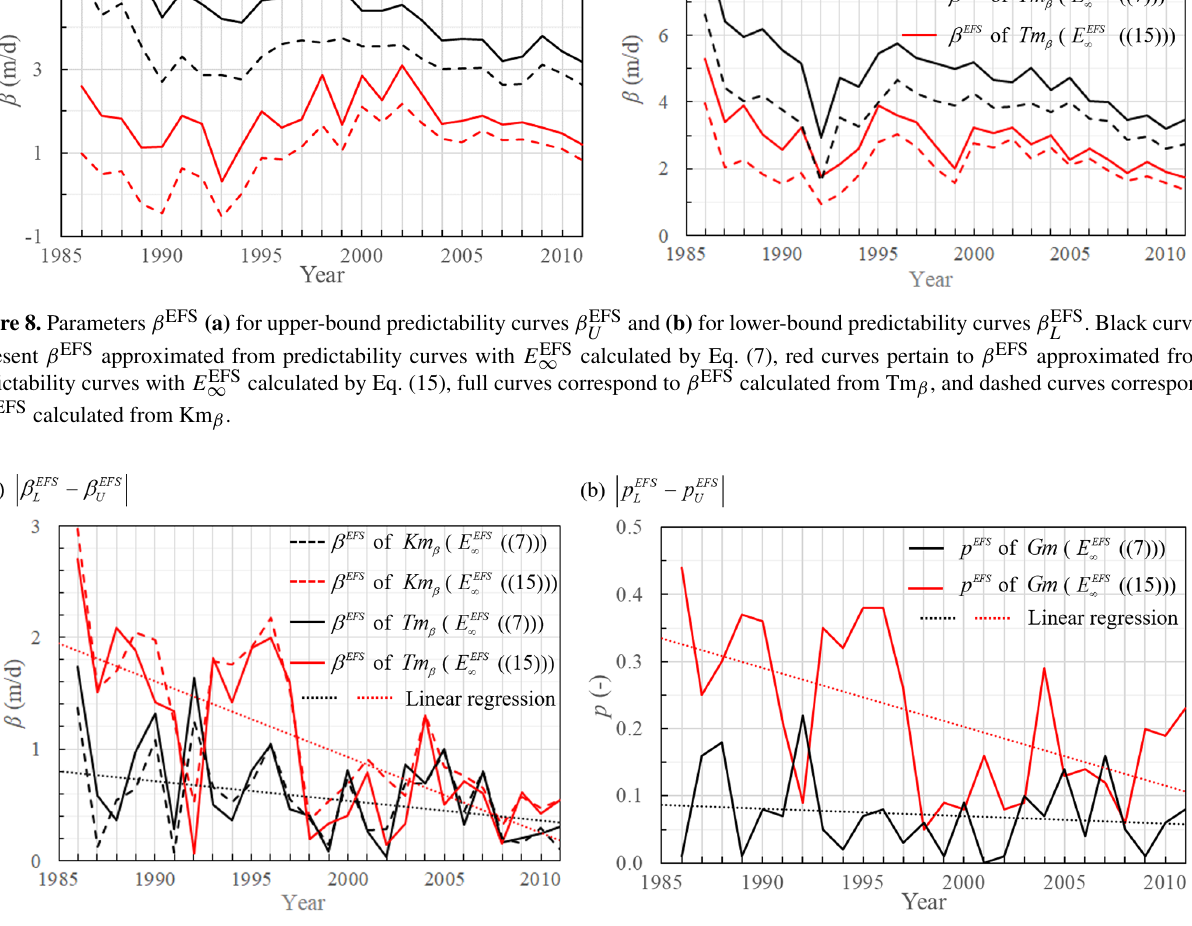
(cid:12) (cid:12) (cid:12) (cid:12) − p EFS p EFS (cid:12) (cid:12) between lower- and upper-bound pre- L U